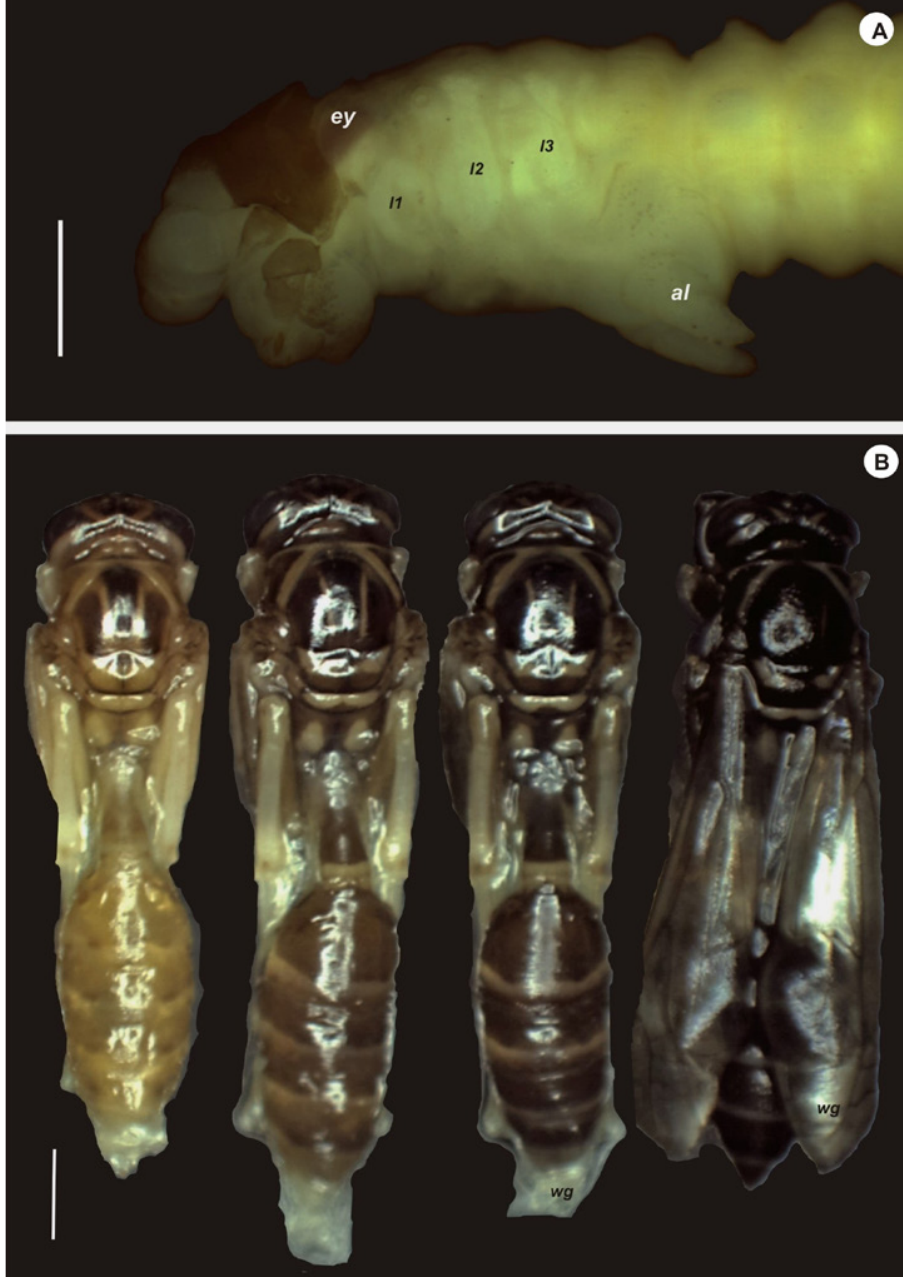
Fig 4 . Lateral view of a pre-pupa (A) and dorsal view of a pupa (B) of Mischocyttarus nomurae (Hymenoptera, Vespidae). al – abdominal lobe, ey – compound eye, l1 – protothoracic leg, l2 – mesothoracic leg, l3 – metathoracic leg, wg – wing. Scale bar: 1